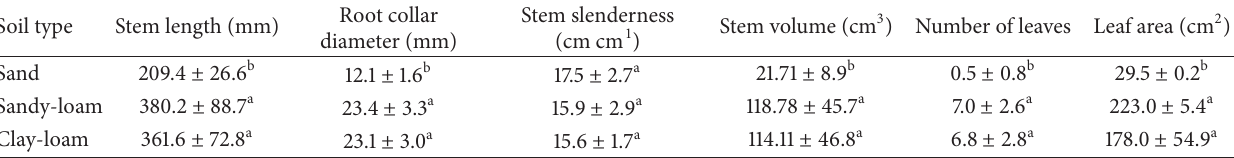
Table 2: Aboveground parameters in J. curcas seedlings grown in three different soils.